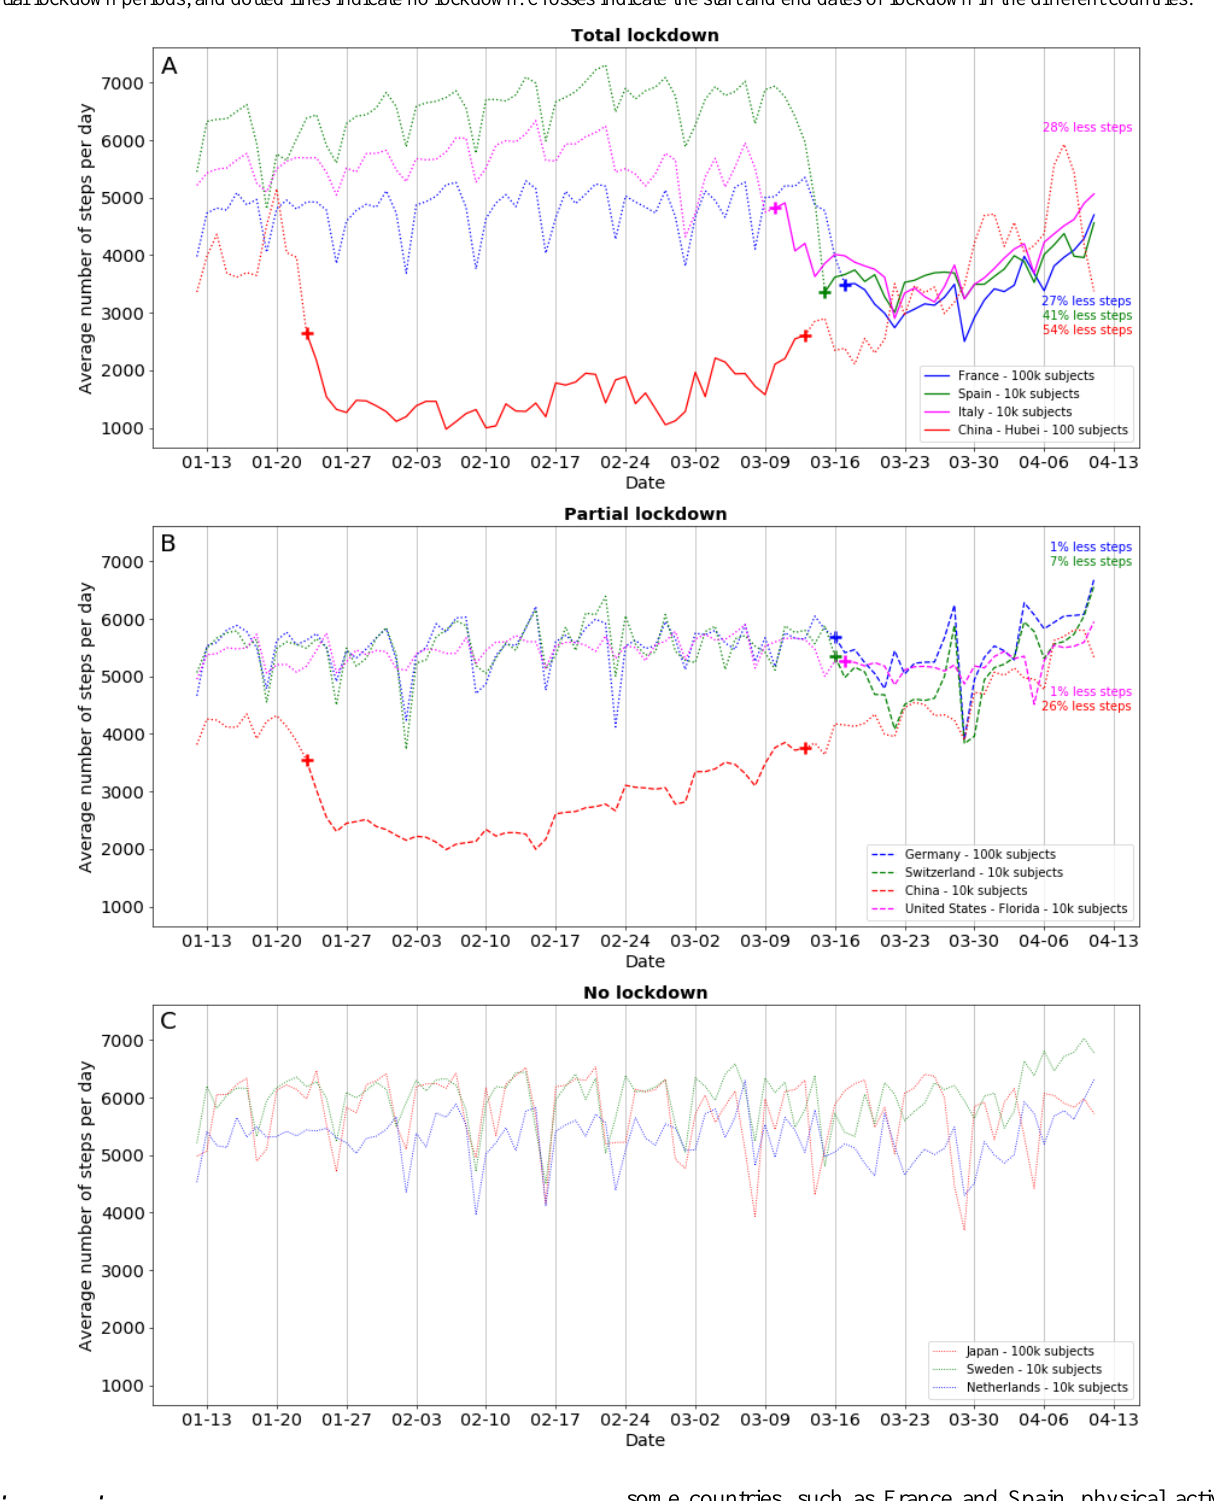
Figure 1. Trajectories of average daily number of steps recorded by activity trackers from January 13, 2020, to April 13, 2020, in a number of representative countries worldwide adopting total (A), partial (B), or no (C) lockdown. Solid lines indicate total lockdown periods, dashed lines indicate partial lockdown periods, and dotted lines indicate no lockdown. Crosses indicate the start and end dates of lockdown in the different